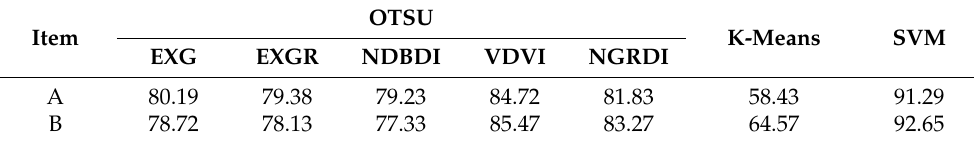
Table 7. Accuracy Evaluation.